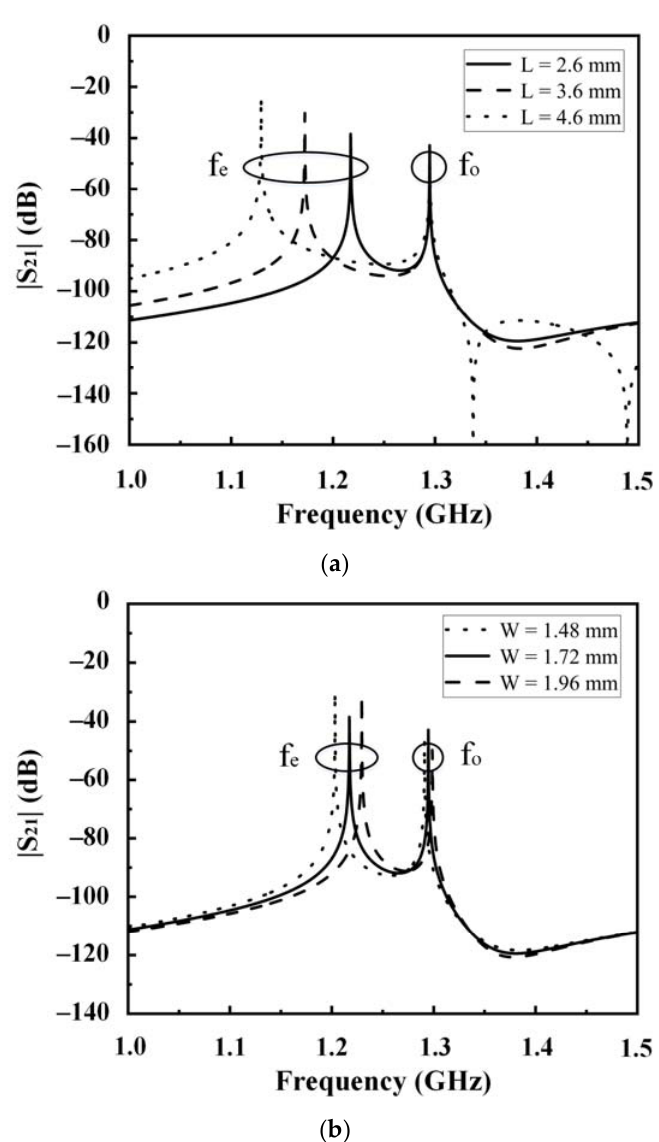
Figure 3. Modal resonant characteristics with varied microstrip line lengths. ( a ) L; ( b ) W.